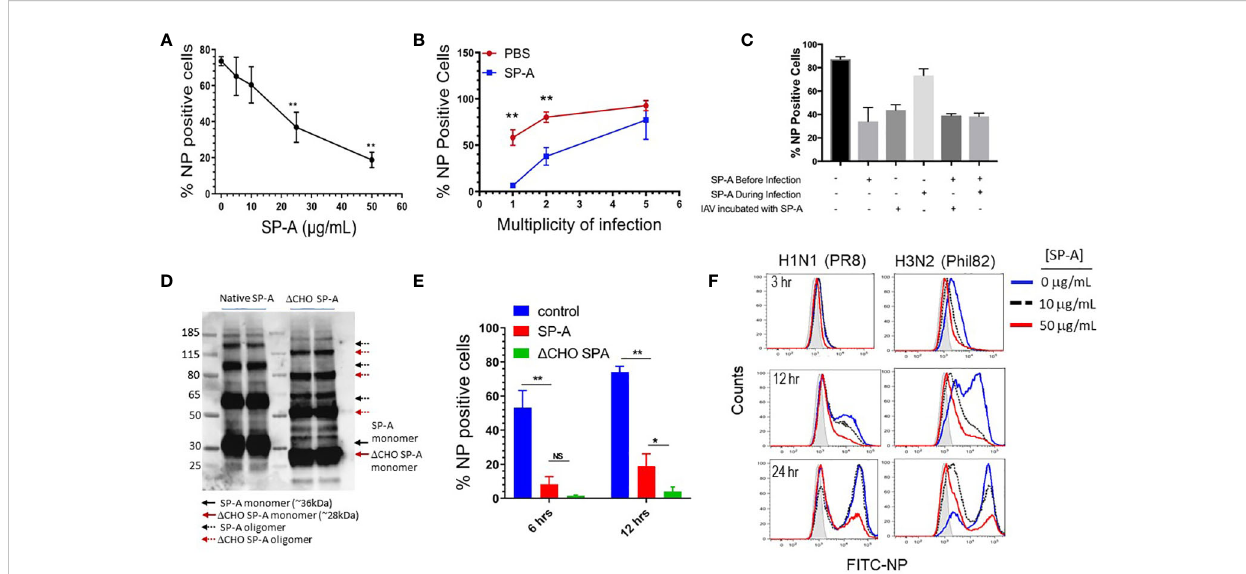
FIGURE 1 SP-A inhibits IAV infection independent of its glycosylation. RAW264.7 cells were cultured overnight at a density of 2 x 10 5 cells/well in 24-well plates and infected with either IAV PR8 (A-F) or IAV Phil82 (F) . Cells were incubated with indicated concentration of virus in 1:1 (v/v) PBS/DMEM